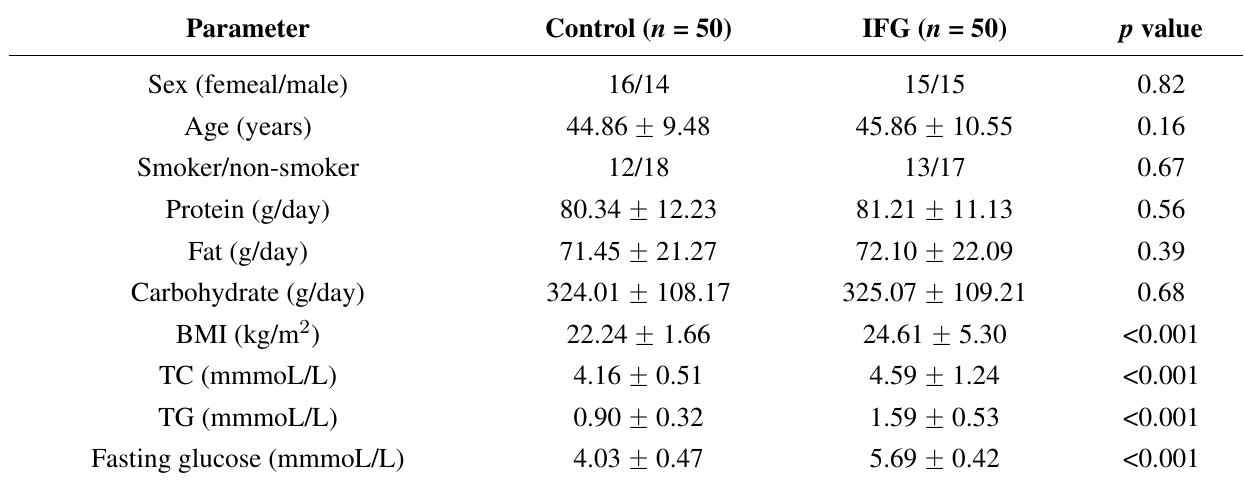
Table 1. Demographic and Clinical Chemistry Characteristics of Human